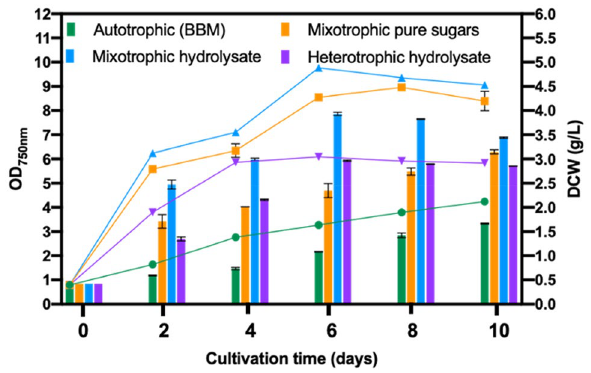
Figure 3. Growth performance in terms of OD 750 and dry cell weight of Chlorella 395 cultivated in various growth media and trophic modes. Lines represent OD 750nm , whereas bars represent